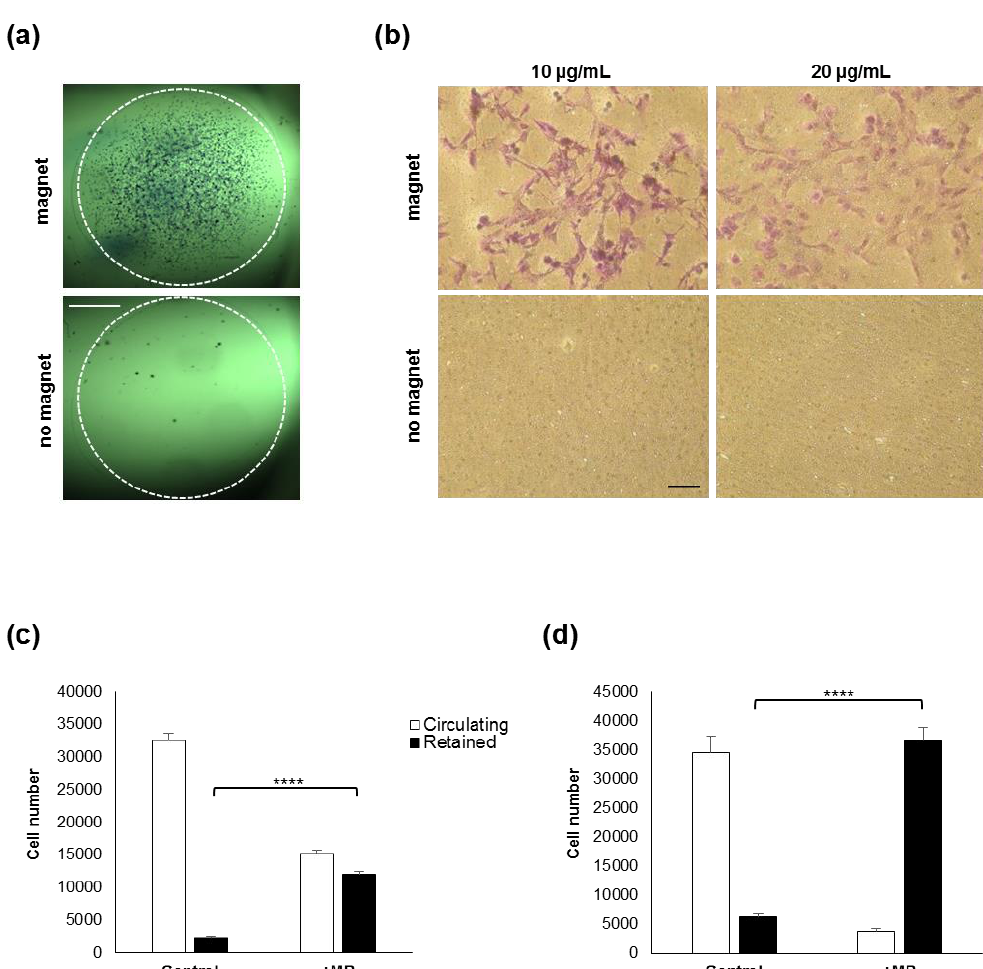
Figure 2. Magnetically assisted recruitment of MSCs in vitro. ( a ) Representative images of toluidine blue staining of labelled MSCs recruited anti-gravitationally from hanging drops following 48 h incubation in the presence (top) or absence (bottom) of a magnet. Dashed circle shows the edge of the drop. Bar = 1 mm. ( b ) In vitro recruitment of adherent cells, labelled with the standard (10 µ g / mL) and double (20 µ g / mL) concentration of MP, attached onto the underside of an insert membrane upon 48 h magnet exposure, visualised by toluidine blue staining. Bar = 100 µ m. ( c , d ) Retention of circulating MSCs in vitro, whereby unlabelled (control) or MP-labelled ( + MP) cells flowing in a circulation model were exposed to the presence of a small ( c ) or large ( d ) magnet for 30 min, before the proportion of cells either immobilised (black bars) or remaining in circulation (white bars) was quantified (**** p < 0.0001).